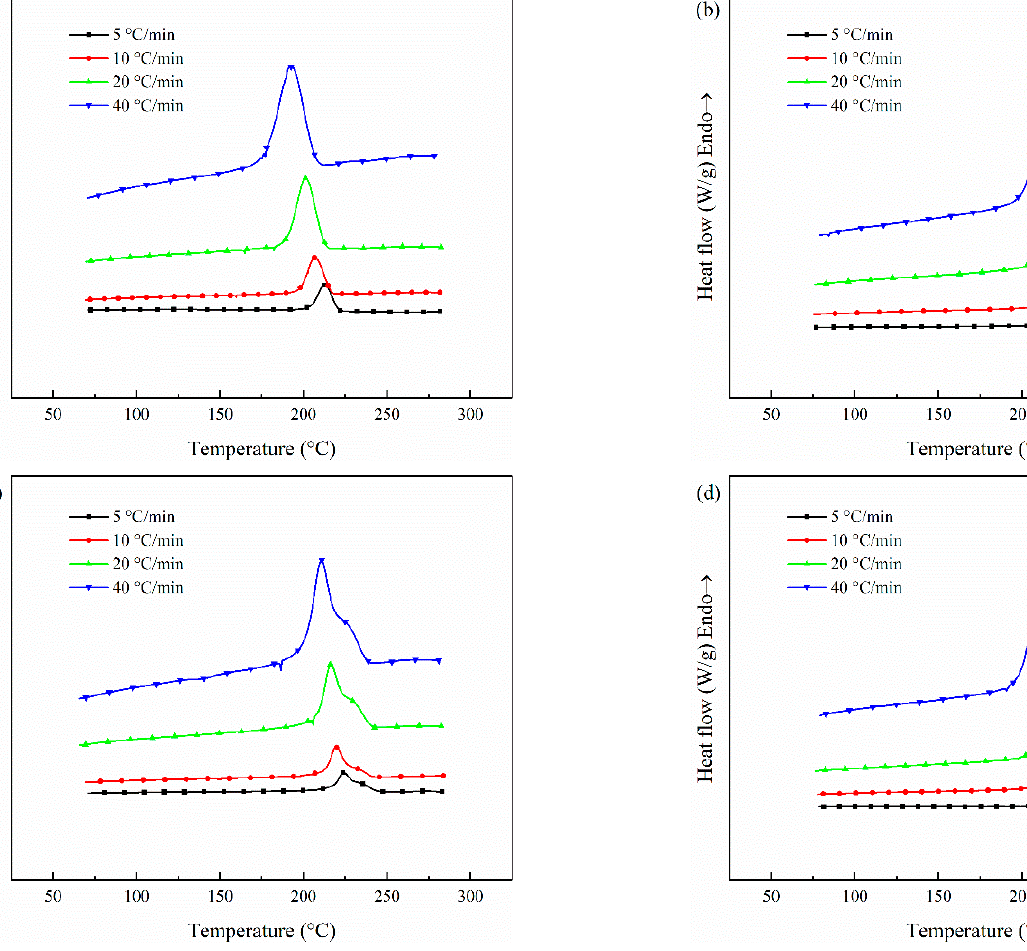
Figure 9. Non-isothermal melting crystallization curves of samples at different cooling rates: ( a ) (56 wt%) CCF/PET, ( b ) (0.1 wt%) CNT/CCF/PET, ( c ) (1.0 wt%) CNT/CCF/PET, ( d ) (2.0 wt%) CNT/CCF/PET.